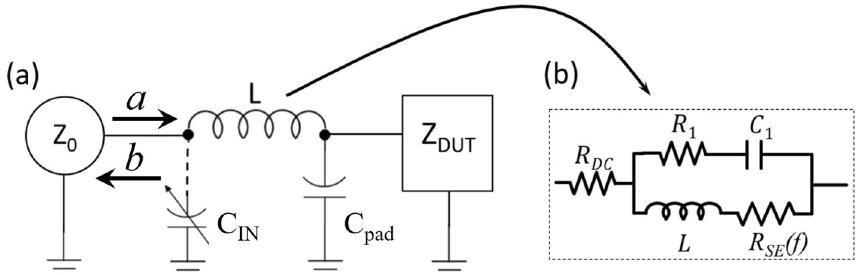
Figure 1. ( a ) Generic 1-port reflectometry setup. Z DUT is a general representation of a device connected to a MN. This impedance was treated as purely resistive in original RF-SET research 14 where it represents device source-drain resistance R SET (cid:31) V g (cid:30) . For gate reflectometry work 1–5,10,11 , DUT corresponds to predominantly capacitive gate impedance. C IN is a tunable capacitor that enables close matching conditions and is discussed at length in this work. ( b ) Realistic model of inductors 15 used in experiments 1–5,10,11